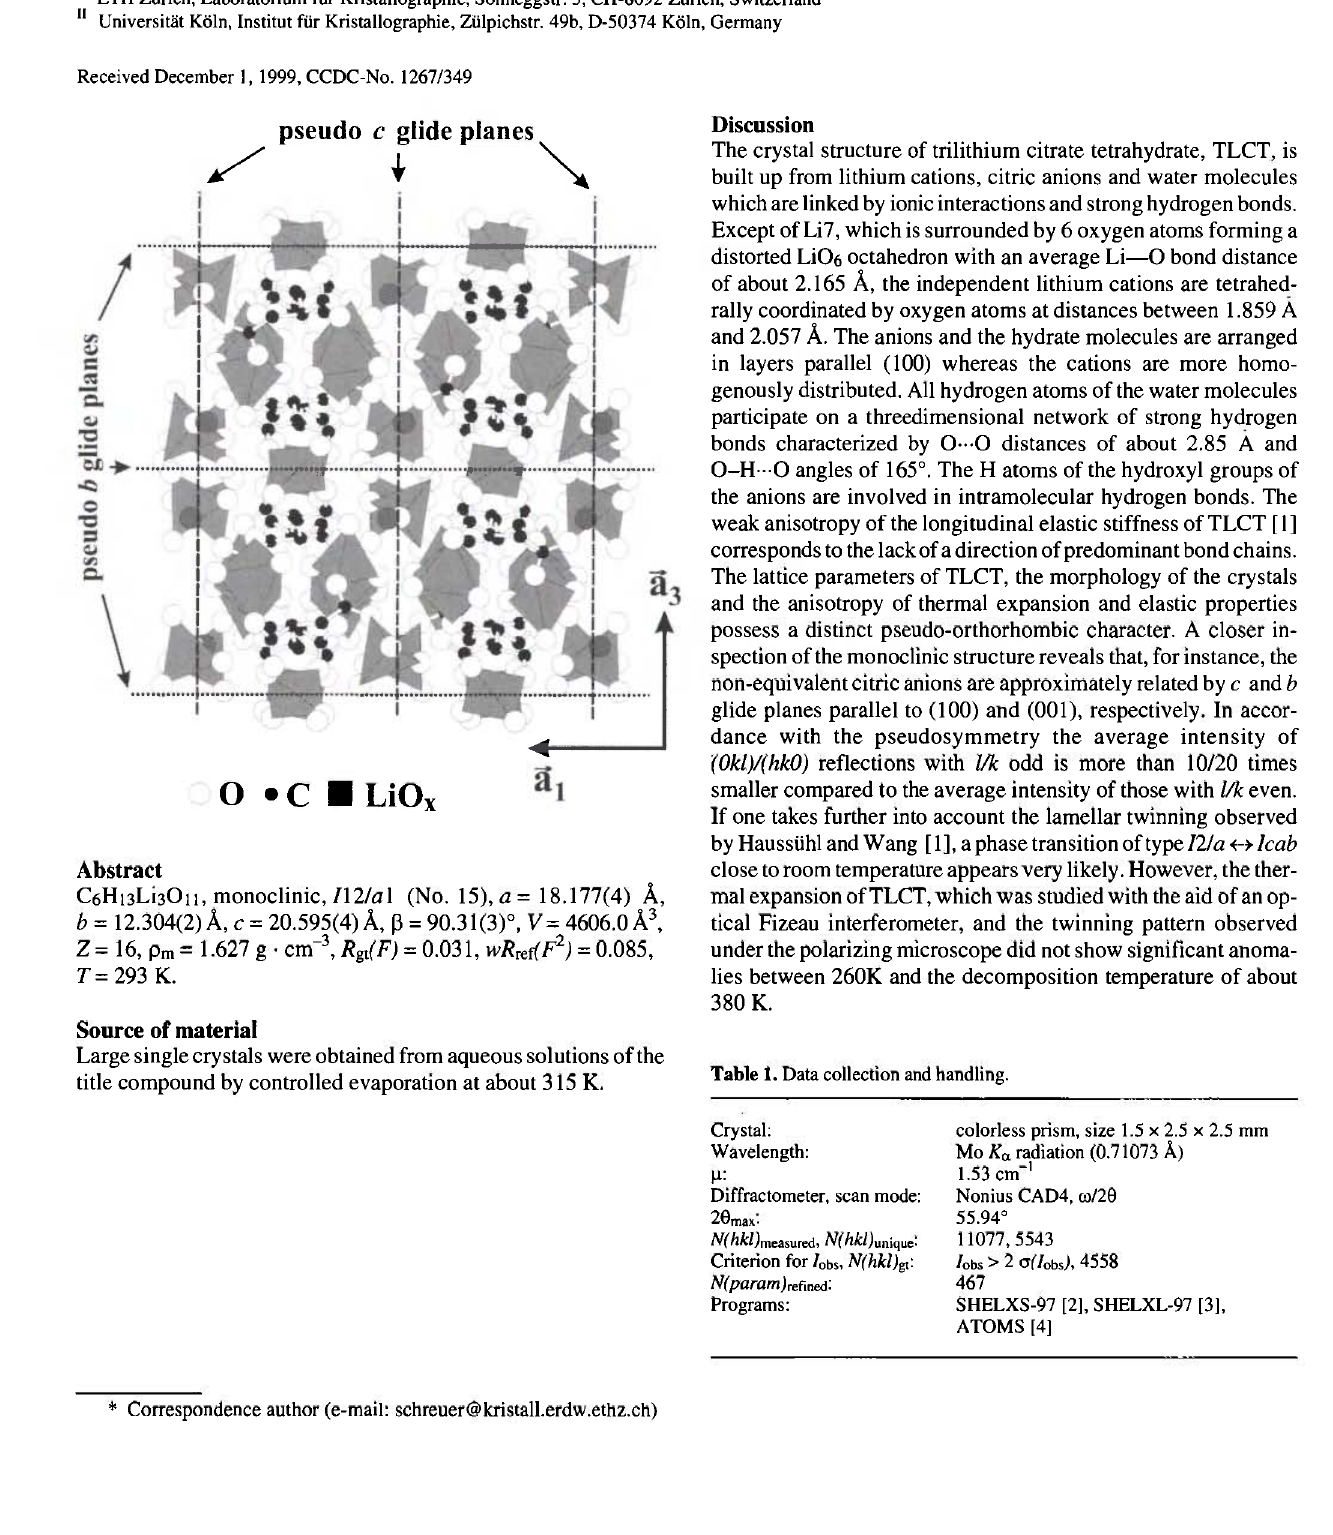
Table 1. Data collection and